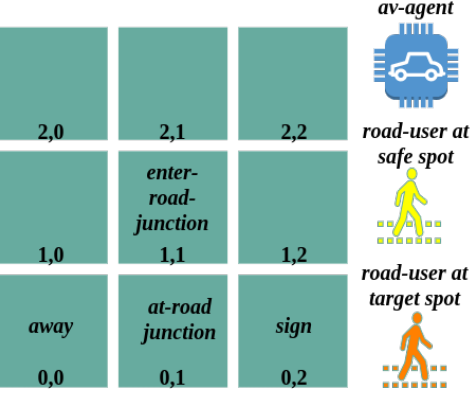
Figure 6. Road Junction grid environment